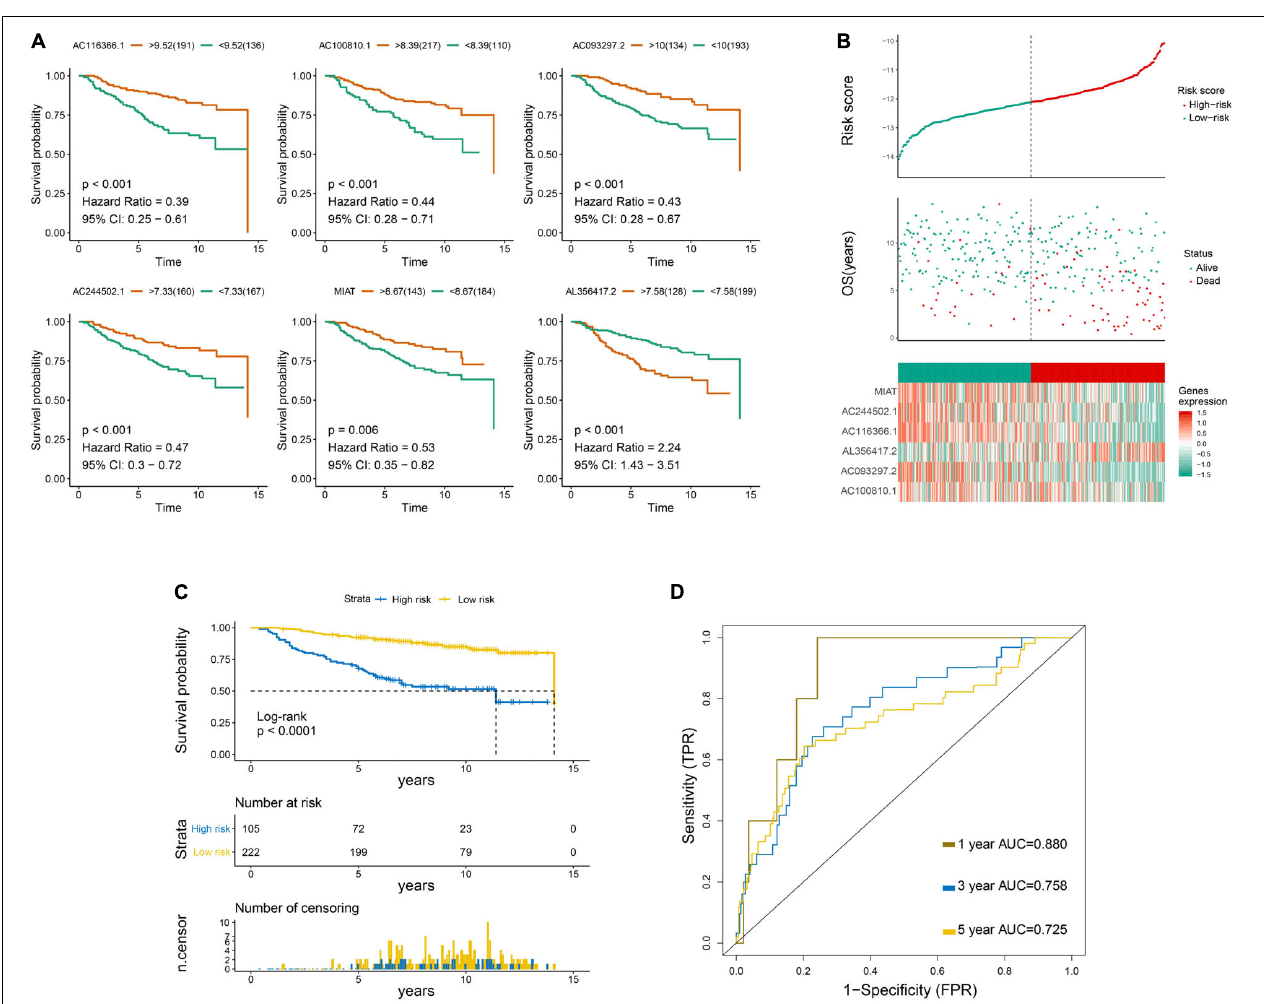
FIGURE 2 | Primary evaluation of the six-LncRNA Signature in the Training Set. (A) Overall survival curves of six lncRNAs. (B) From top to bottom are the risk score, survival status distribution, and six-lncRNA expression level of each patient. (C) Overall survival curves of the prognostic signature, in which the blue line represents the high-risk subgroup and the yellow line represents the low-risk subgroup. (D) The 1-, 3-, and 5-year survival receiver operating characteristic curves.